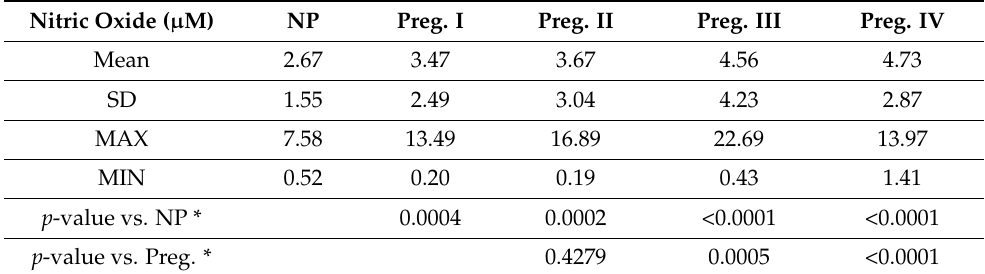
Table 1. Nitric oxide (NO) equivalent nitrite levels ( µ M) in the saliva of pregnant women at different gestational ages and non-pregnant women.